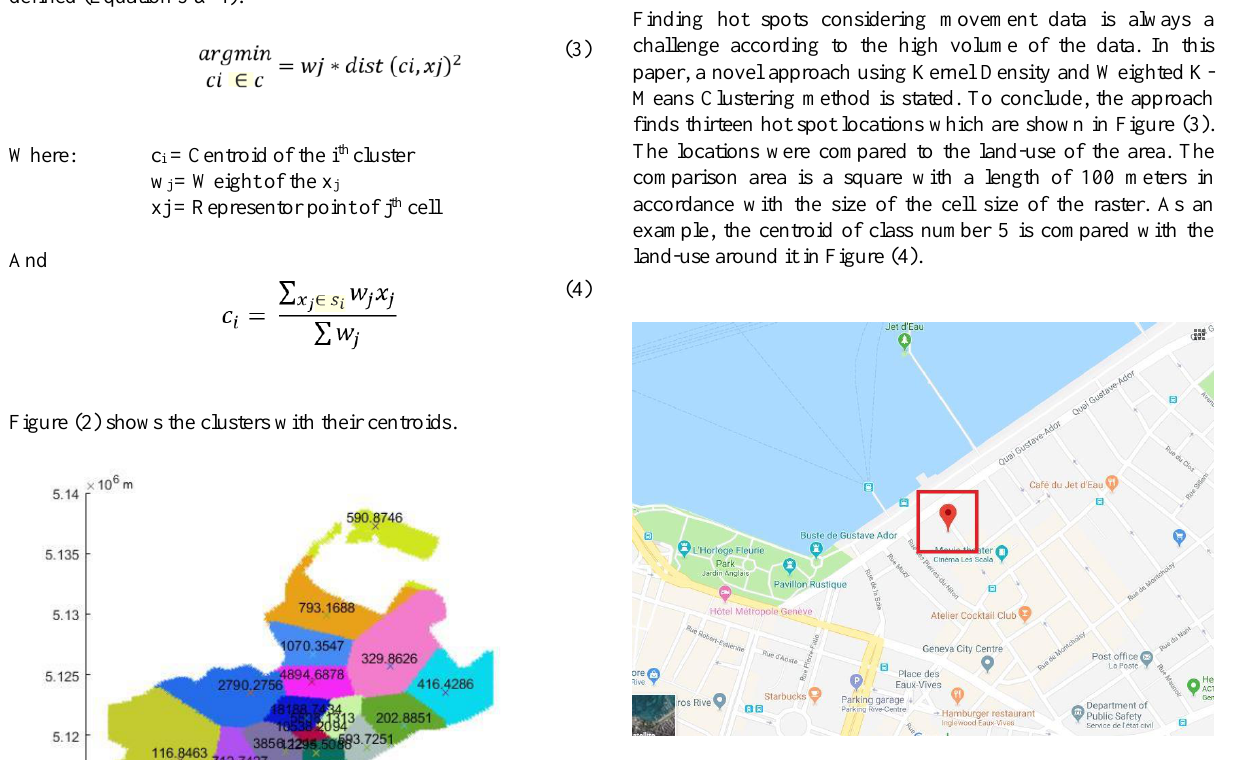
Figure (4) Centroid of Class number 4 and the area around it The area is so near to the City Center, Movie Theater, many restaurant, and clubs. It is admittedly easy to interpret why the location represents a hot spot area of the city. The other locations as well can be acceptably interpreted. There are four centroids which represent the entertainment venues, two represent Geneva Landmarks, and six represent intersections which two main roads intersect. There was just one class centroid which has no acceptable